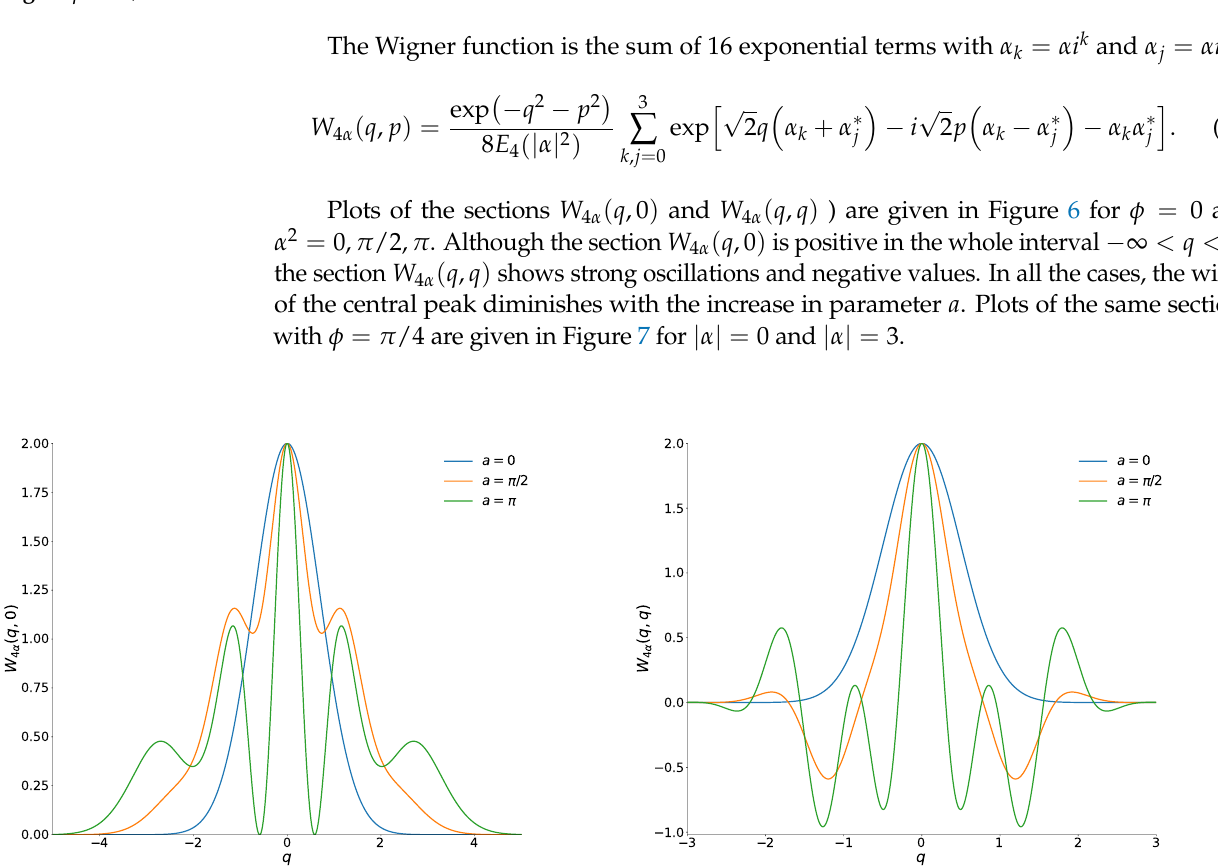
Figure 6. The sections of function W 4 α ( q , p ) for different values of real parameter α =